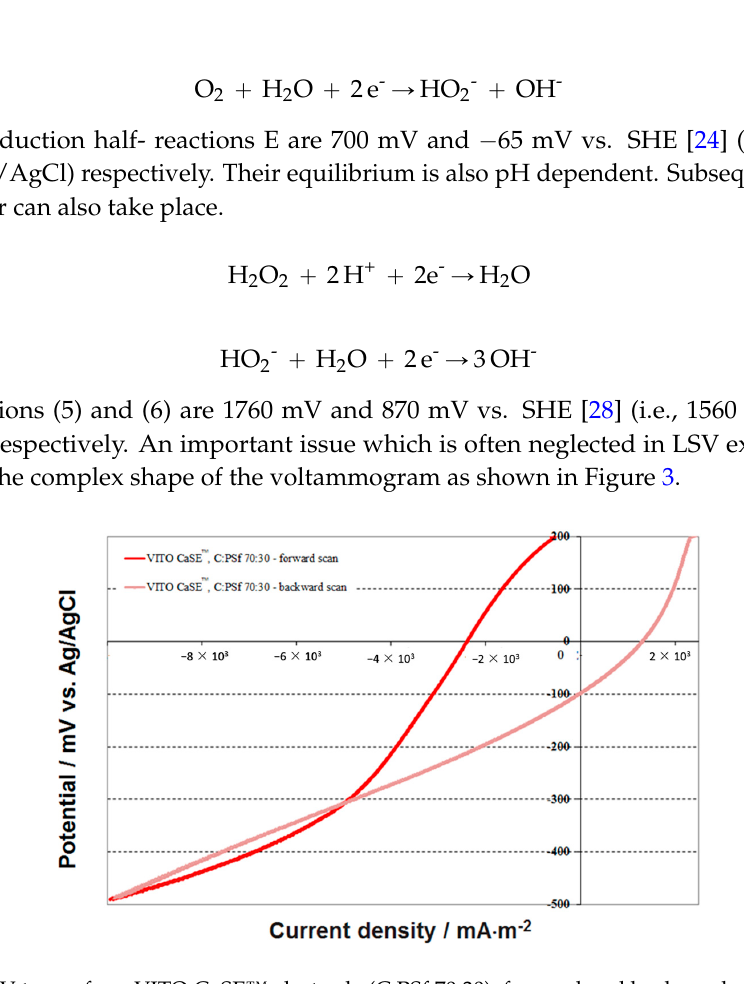
Figure 3. LSV traces for a VITO CaSE™ electrode (C:PSf 70:30), forward and backward scan (scan rate: 1 mV·s − 1 ).